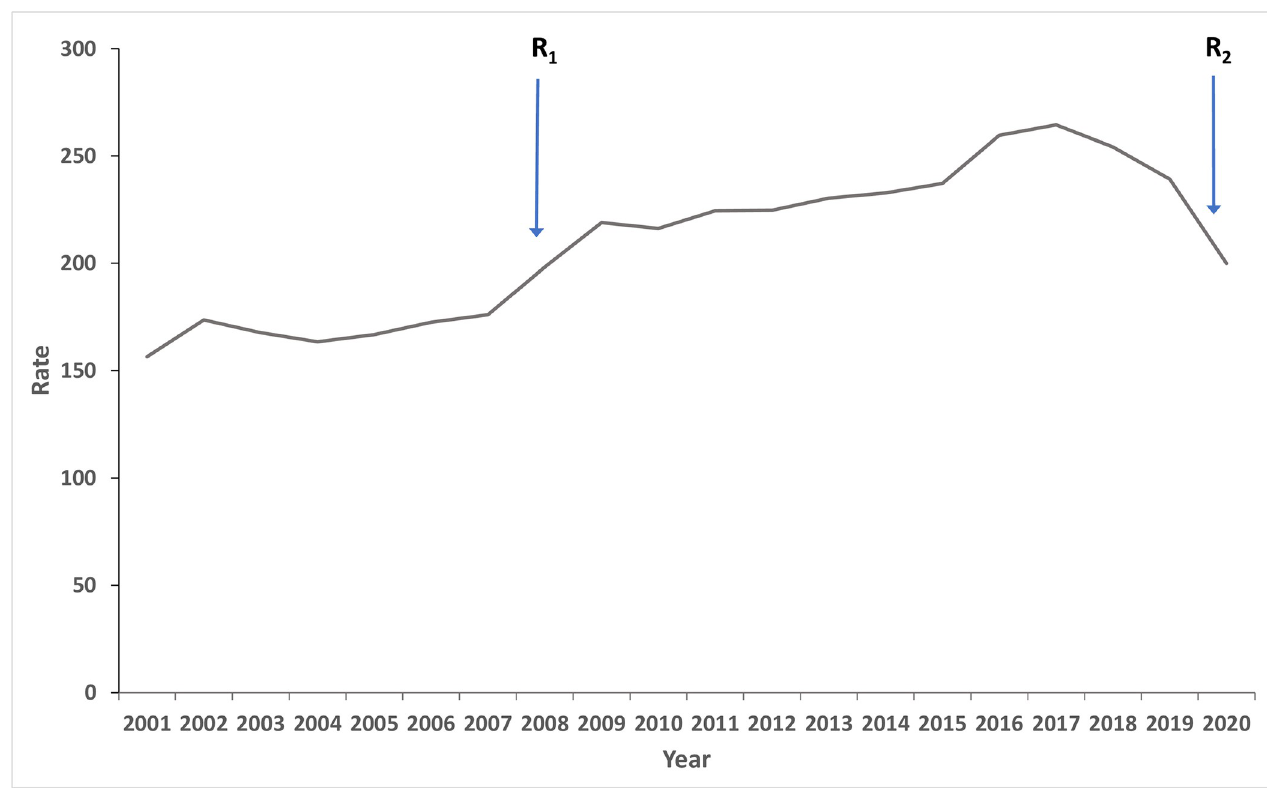
Fig 3. Annual incidence of tonsillectomy procedures, 2000–01 to 2019–20. Rate expressed in procedures per 100,000 person-years. R 1 arrow marks the release of the Guideline Indications for Tonsillectomy and Adenotonsillectomy released by the Royal Australasian College of Physicians and The Australian Society of Otolaryngology Head and Neck Surgery in July 2008. R 2 arrow marks the introduction of Australian Government’s restrictions on elective surgery to free hospital resources to during the COVID-19 pandemic. Data obtained from the National Hospital Morbidity Database for the period 1 July 2000 to 30